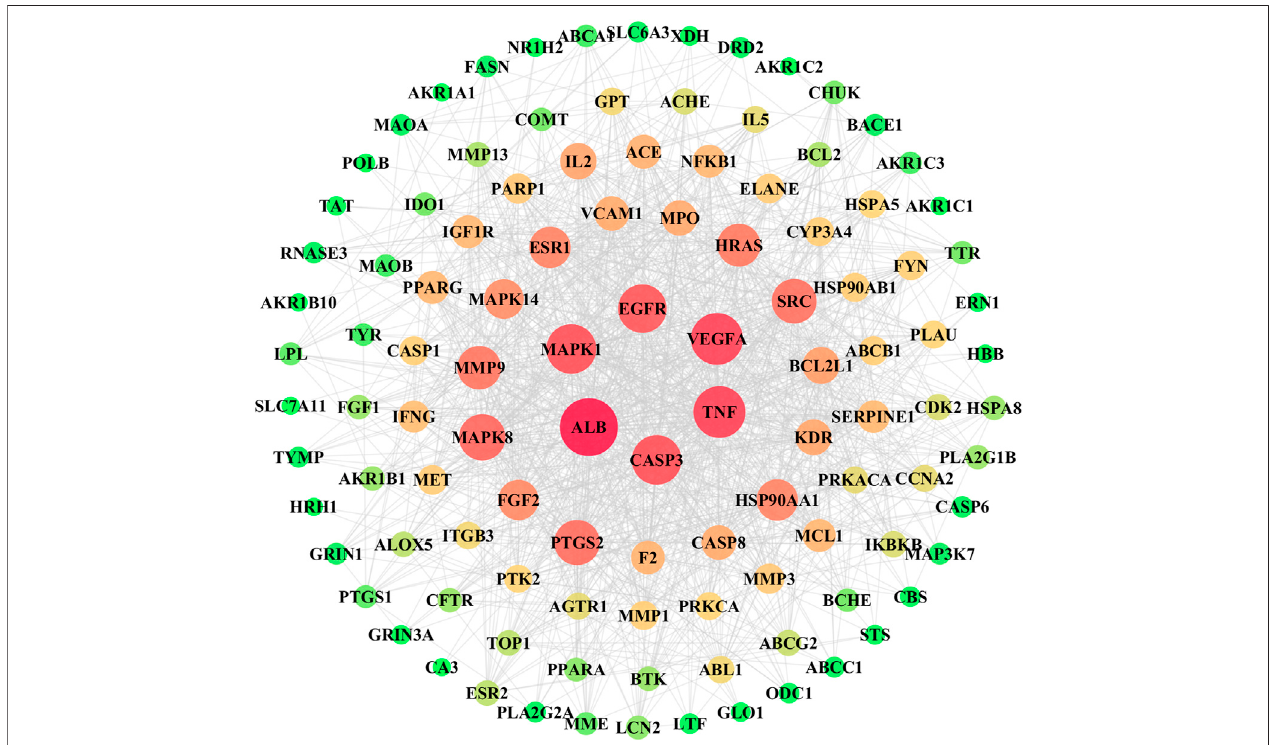
FIGURE4| Clusters ofthe compound-disease target ’ PPInetwork.The sizeand thecolorofthe noderepresentsthevalueofthedegree, thethickness ofthe side indicates the value of the Combine score.